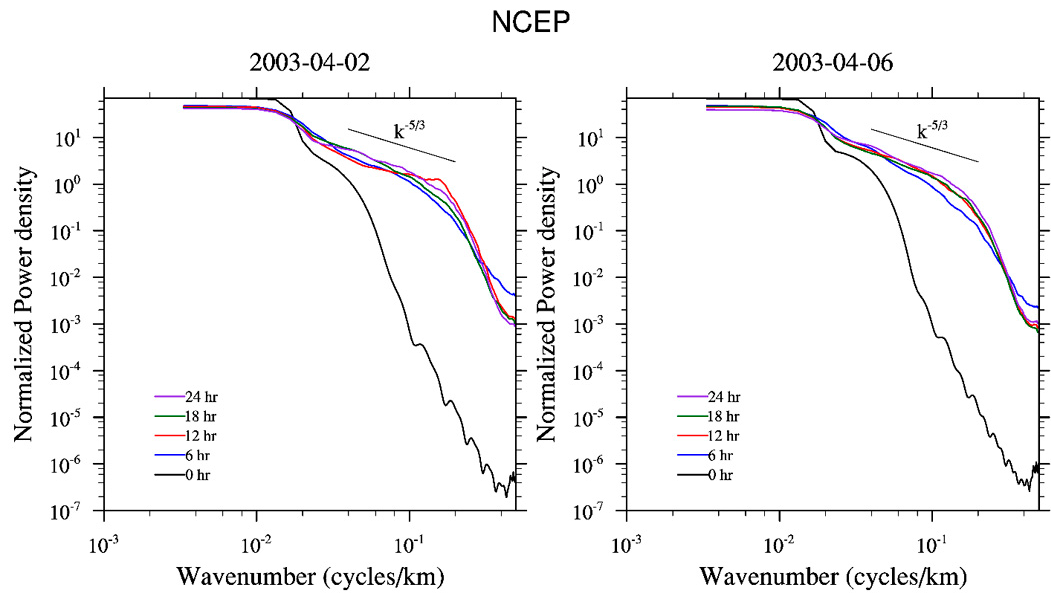
Figure 4. Kinetic energy spectra at several spin-up times when NCEP ICs/BCs were used.